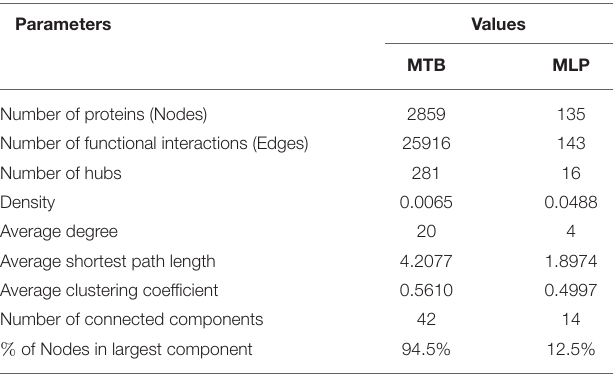
TABLE 1 | Comparing network parameters and values in MTB and MLP